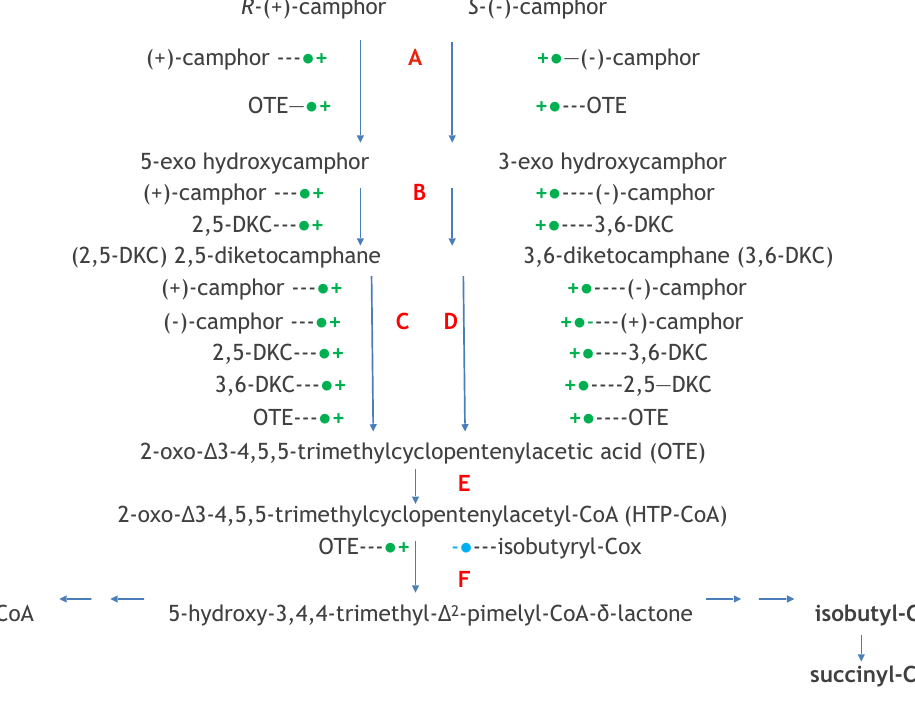
Figure 13. Transcriptional controls of the pathway of (+)- and ( − )-camphor degradation in P. putida ATCC 17453 • + = induction: −• = repression: A = camphor 5-monooxygenase ( camCAB ): B = exo -hydroxycamphor dehydrogenase ( camD ): C = 2,5-diketocamphane 1,2-monooxygenase ( camE 25-1 + camE 25-2 ); D = 3,6-diketo- camphane 1,6-monooxygenase camE 36 ); E = 2-oxo- (cid:52) 3 -4,5,5-trimethylcyclo-pentenylacetyl-CoA synthetase ( camF1 + F2) ; F = 2-oxo- (cid:52) 3 -4,5,5-trimethylcyclo-pentenylacetyl- CoA monooxygenase ( camG